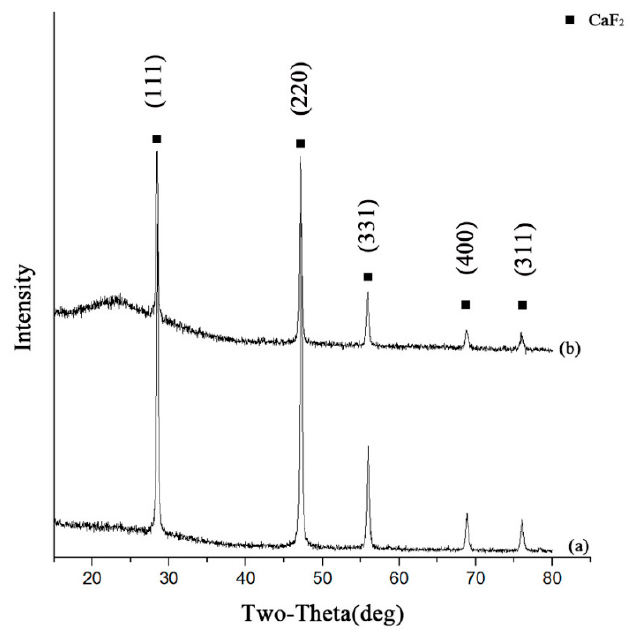
Figure 1. XRD patterns of ( a ) pure CaF 2 and ( b ) CaF 2 @SiO 2 .